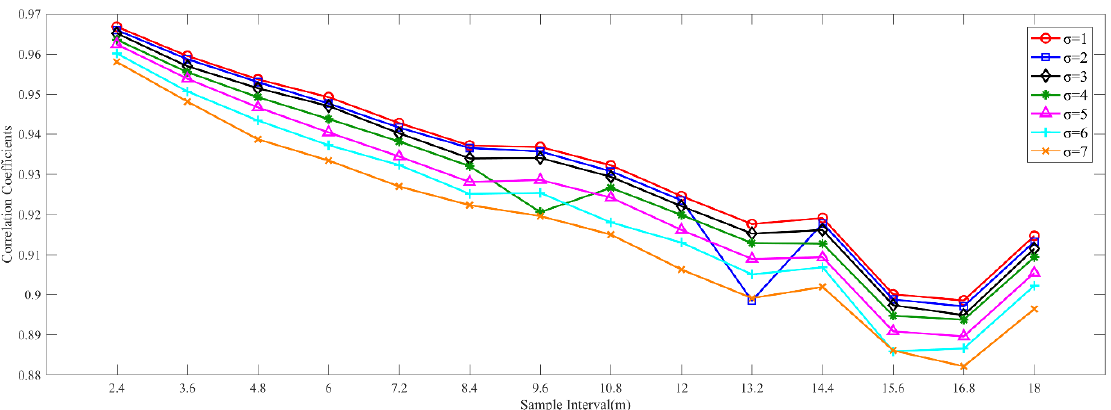
Figure 4. The correlation coefficients between the complete manual radio map and adaptive path loss model interpolated radio maps, which are generated by sparse RPs with different intervals and standard deviations.